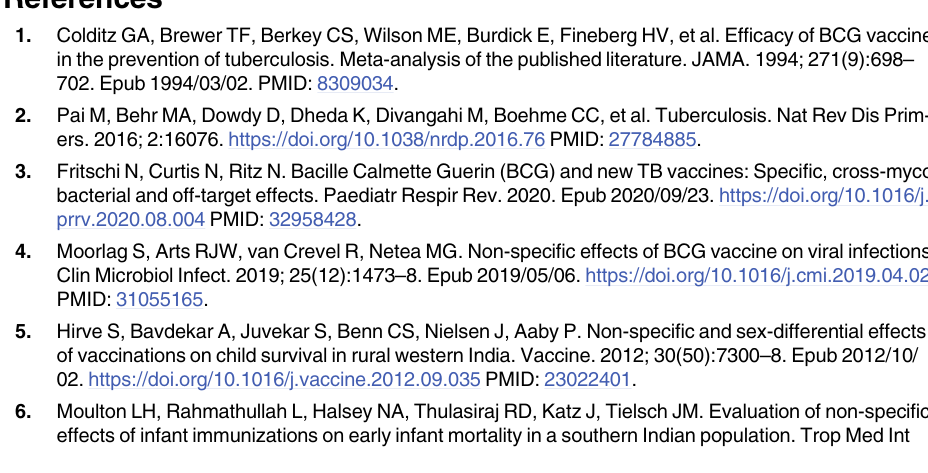
S1 Table. Names, sources, dilutions, and catalog numbers for each antibody used in this study.